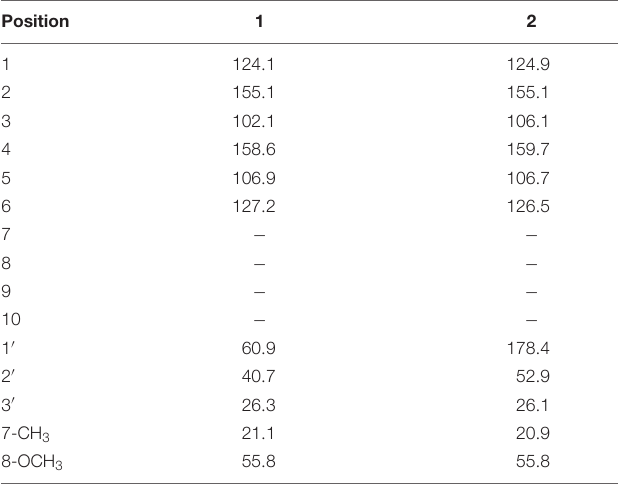
TABLE 2 | 13 C-NMR (CDCl 3 , 75 MHz) data of compounds [ 1 and 2 ] in ppm.